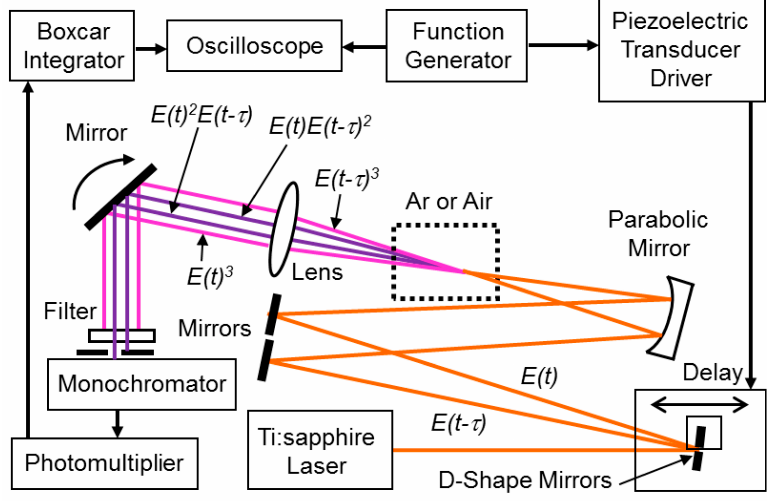
Figure 2. Experimental apparatus for THG-frequency-resolved optical gating